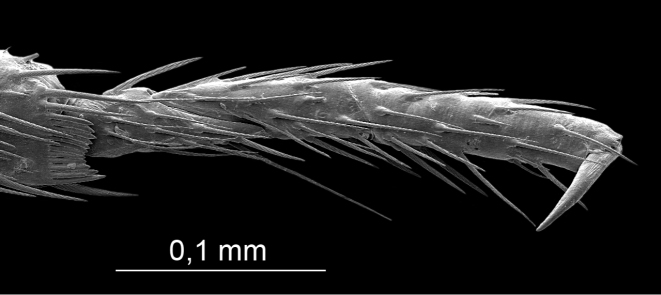
S.henryi, male, 1st leg tarsus.